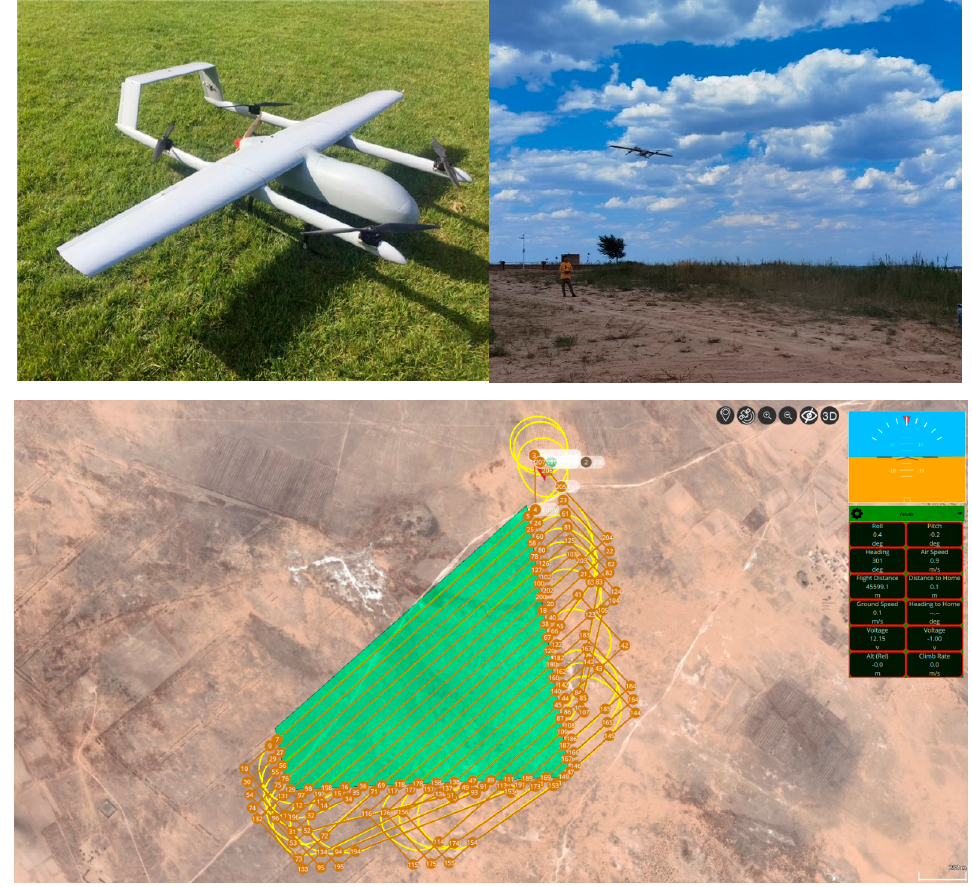
Figure 11. The VTOL UAV in flight test.